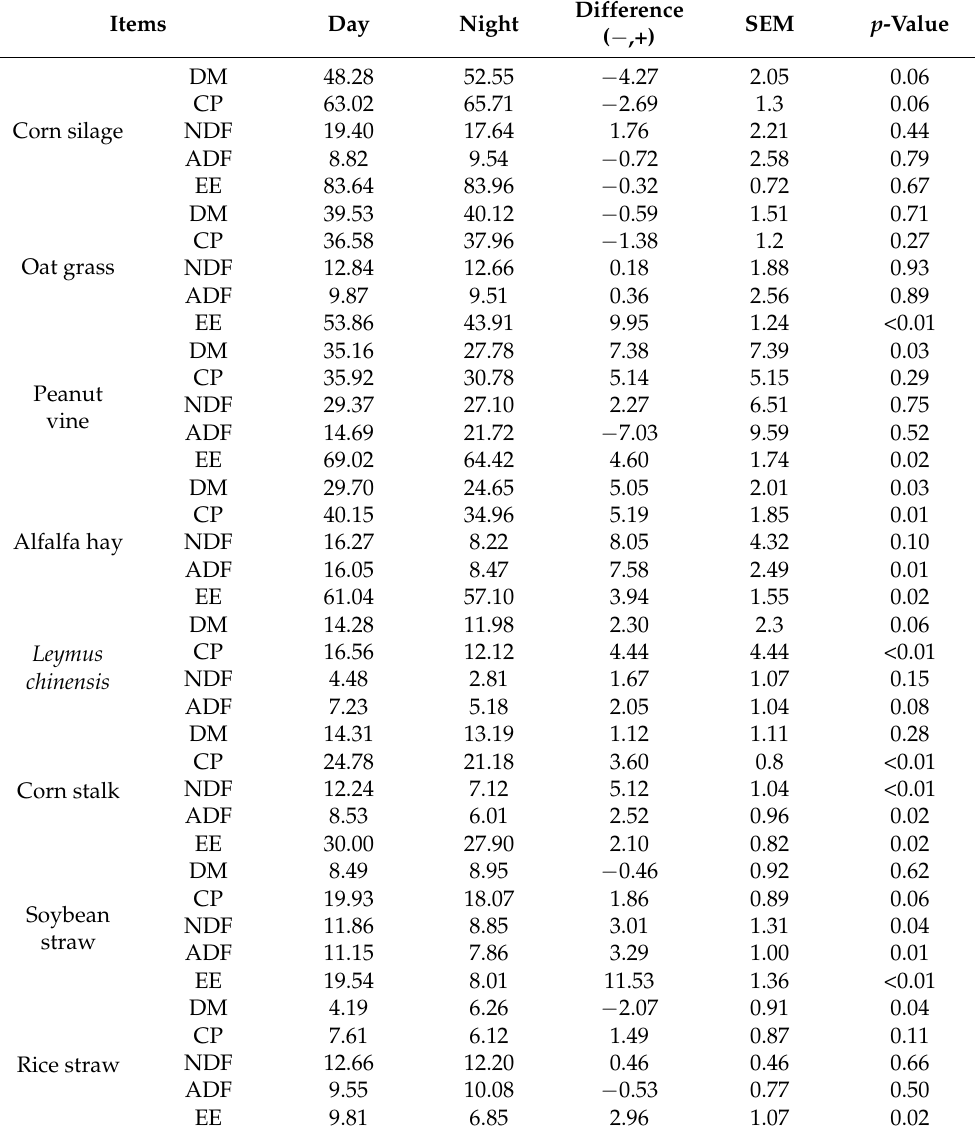
Table 8. Rumen digestibility of roughage nutrients during daytime and nighttime (%, dry